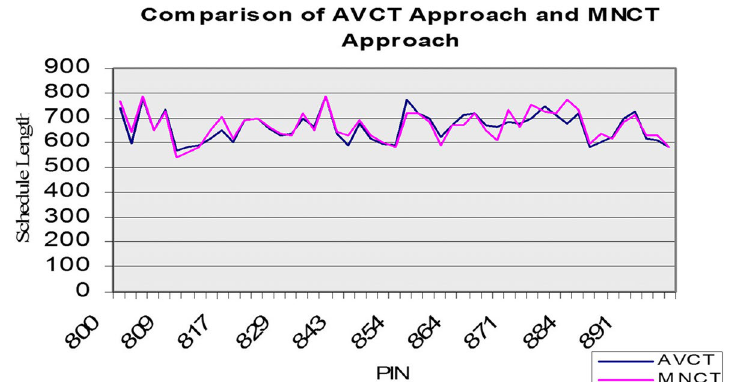
Fig. 10 Variations in schedule length obtained from the AVCT approach and MNCT approach